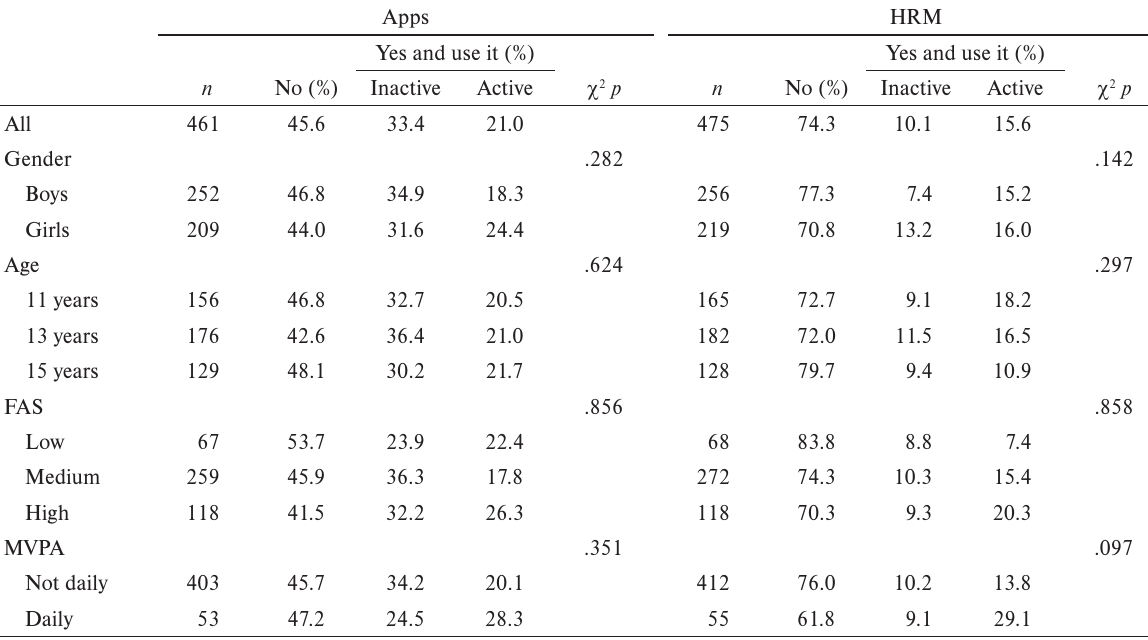
Proportion of ownership and use of apps and HRM with chi-square tests of independence of study demographics